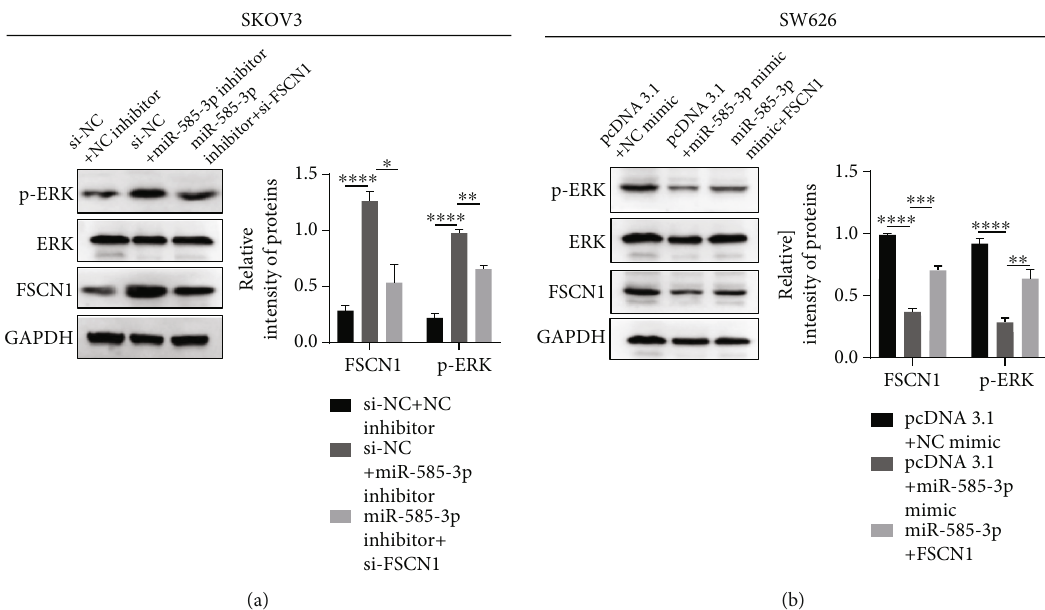
Figure 5: E ff ect of miR-585-3p targeting FSCN1 on protein phosphorylation of ERK. (a) Western blot test was used to detect the changes of p-ERK, ERK, and FSCN1 protein expression in SKOV3 cells of each group. (b) Western blot test was used to detect the changes of p-ERK, ERK, and FSCN1 protein expression in SW626 cells of each group. ∗ P < 0 : 05 , ∗∗ P < 0 : 01 , ∗∗∗ P < 0 : 001 , and ∗∗∗∗ P < 0 : 0001